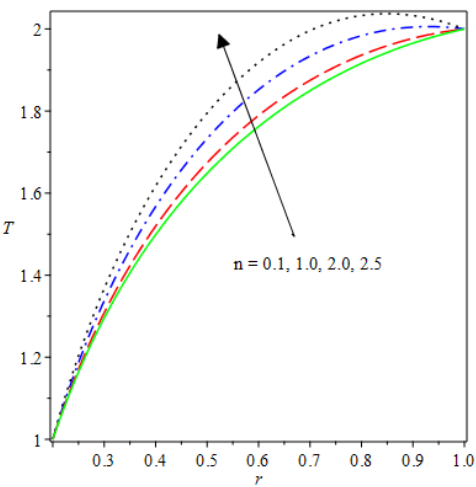
Figure 3. Temperature field for increasing ( λ ) .